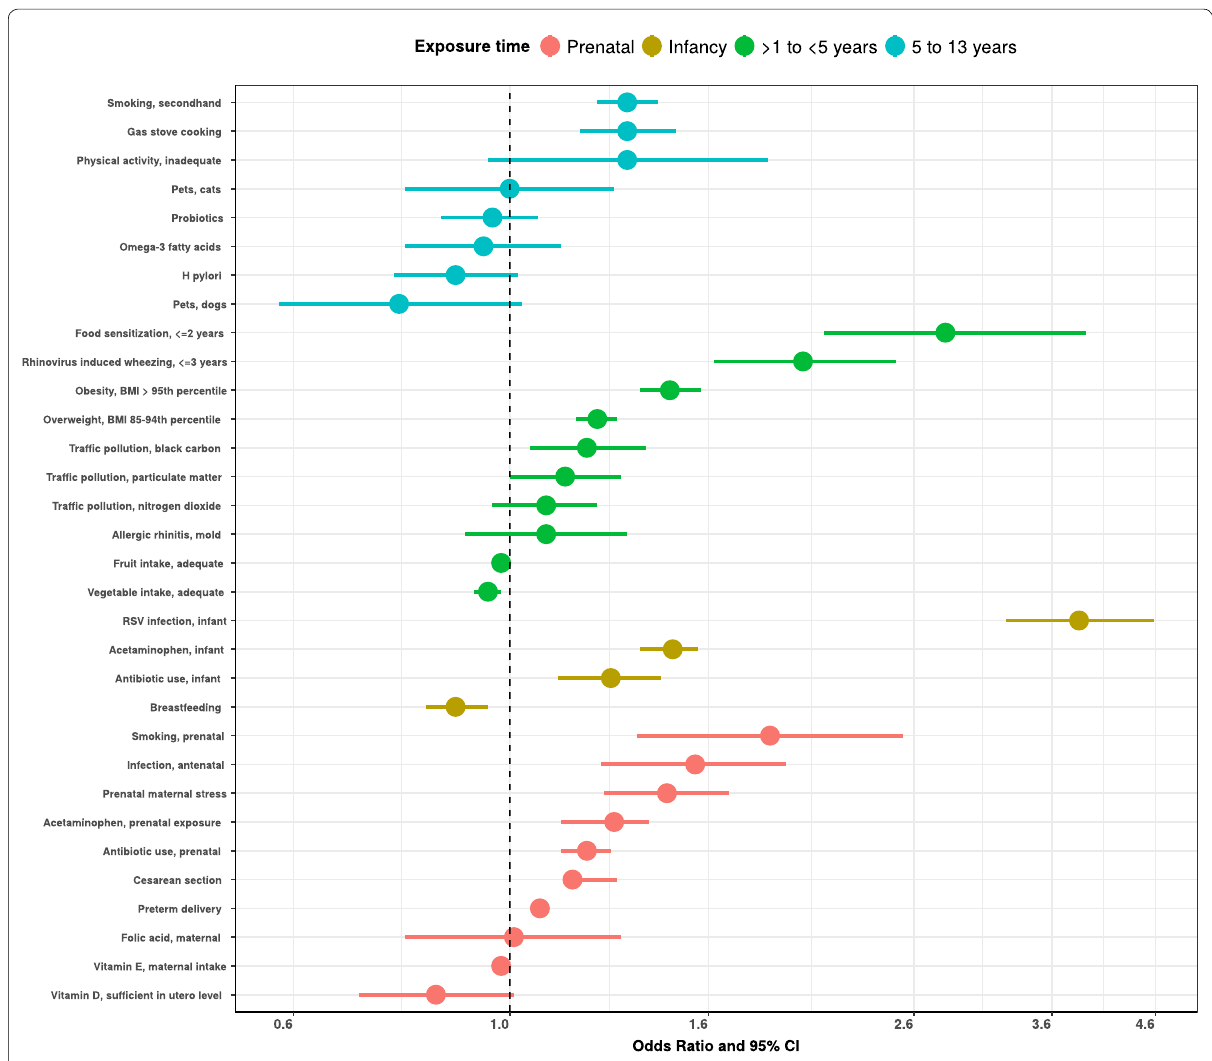
Fig. 1 Association of risk factors for asthma development within age exposure windows. The four age exposure windows are prenatal, 0–1, < 5, and 5–13 years. Odds ratios and 95% confidence intervals are shown ranked by effect size and directionality. References used to determine point estimates for this figure: smoking, secondhand [69]; gas stove cooking [96]; physical activity, inadequate [64]; pets, cats [57]; probiotics [97]; omega-3 fatty acids [98]; H. pylori [99]; pets, dogs [57]; food